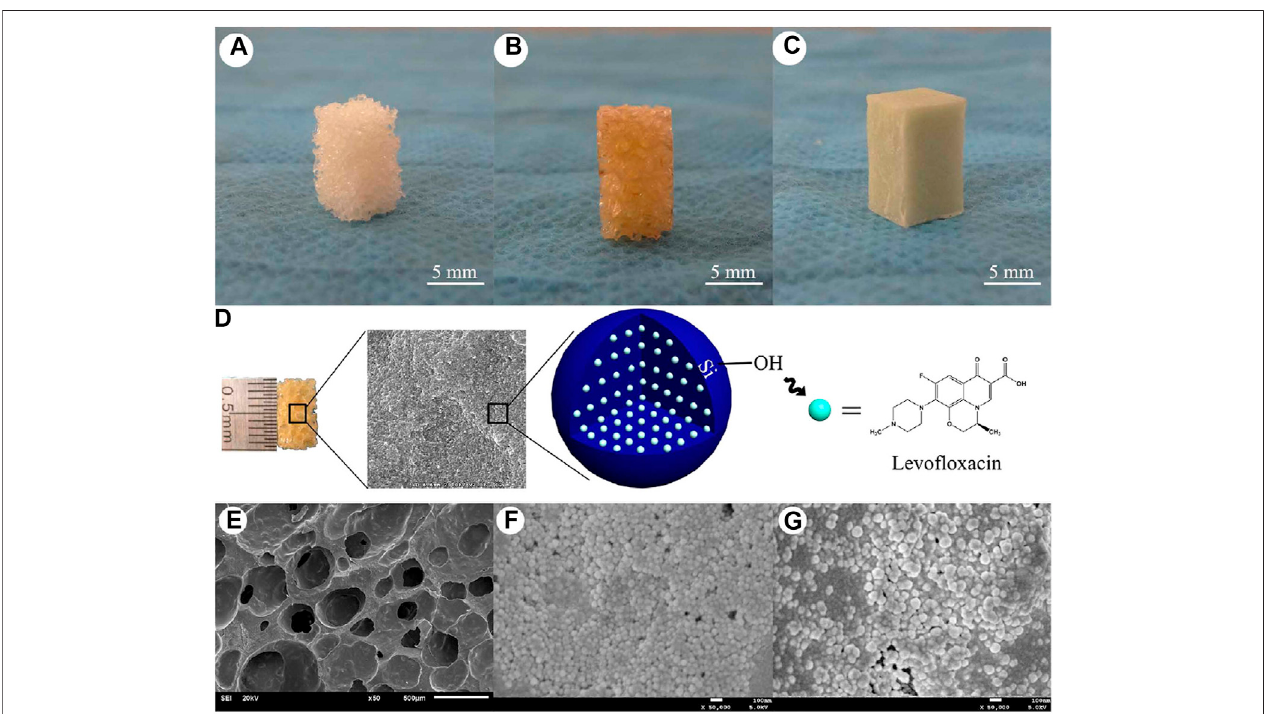
FIGURE 10 | The shape and internal structure of new synthetic composite scaffolds. The n-HA/PU composite porous scaffolds were manufactured using the situ foaming method. (A) The size of the material was 10 mm × 6 mm × 6 mm; (B) HA/PU scaffolds were combined with MSNs, which contained different concentrations of levo fl oxacin; (C) PMMAcementwhichcontained1or5 mglevo fl oxacinwasusedasapositivecontrolgroup; (D) Levo fl oxacinwassuccessfullyloadedwithmesoporous silica nanoparticle via electrostatic attraction; (E) Scanning electron micrographs of the n-HA/PU scaffold; (F) 1 mg Lev@MSNs/n-HA/PU; and (G) 5 mg Lev@ MSNs/n-HA/PU. SEM micrographs of the n-HA/PU scaffold which has many pores (E) . It can be observed from the micrographs that there are many MSNs located on the walls of the macropores, which contain either 1 mg (F) or 5 mg (G) levo fl oxacin in each material. Reprinted from Wang et al. (2017). (Open